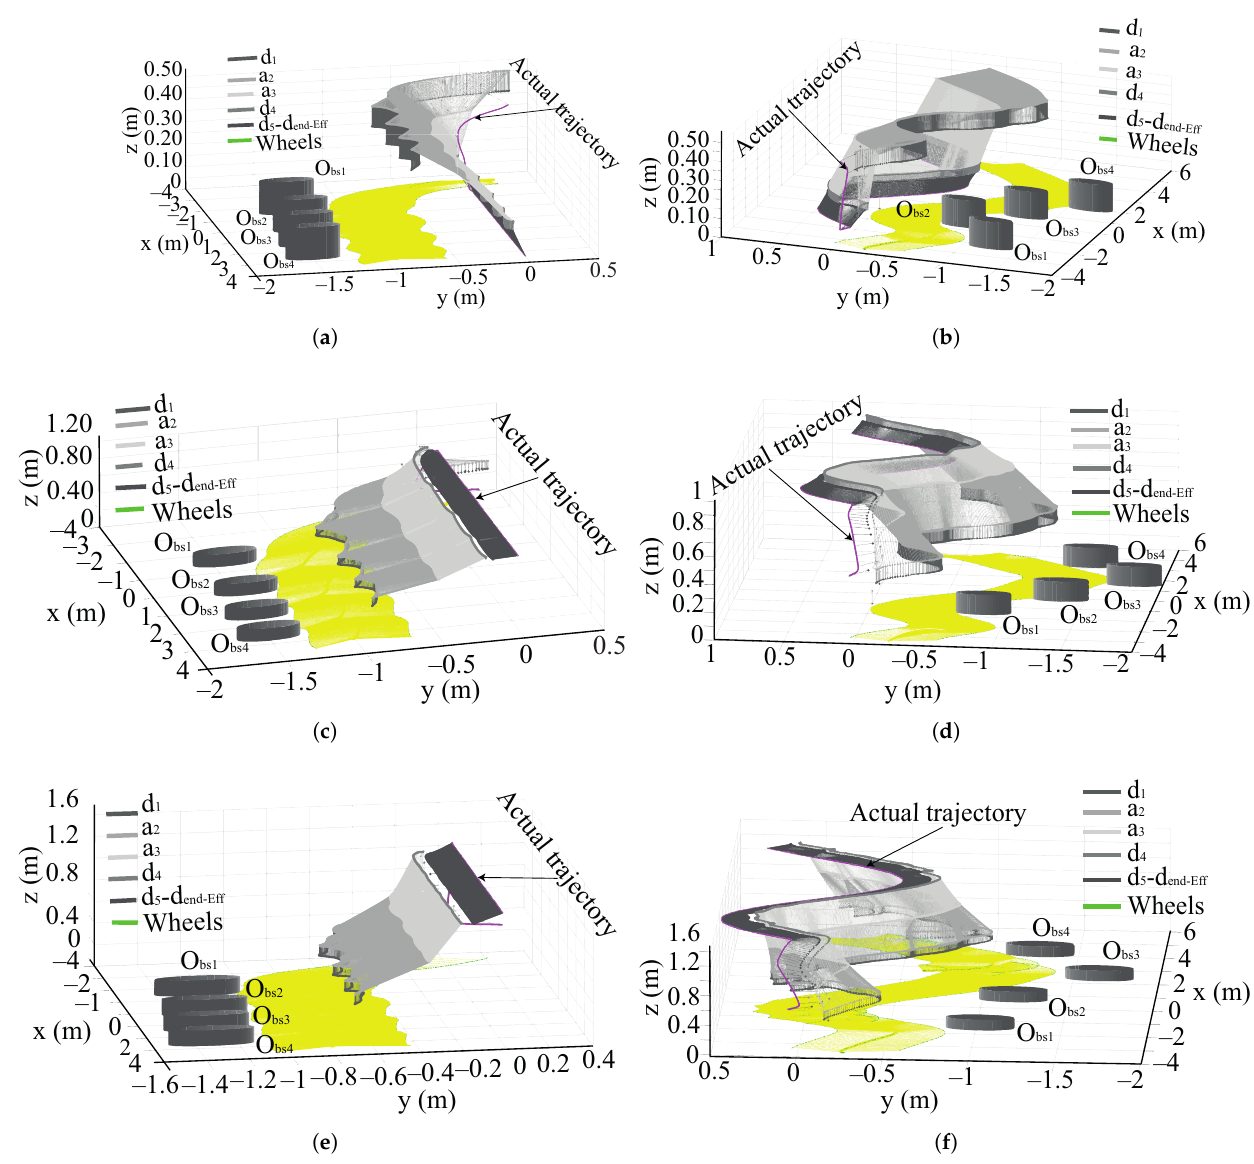
Figure 7. The solid magenta line describes the sinusoidal and straight printing profiles. ( a – f ) show the tests carried out for three heights, z 1 , z 2 and z 3 for a sinusoidal profile of 7 m radius and a straight profile of 6 m. For the sinusoidal building element, the shape of the printing workspace is also sinusoidal. For printing profile heights z 1 and z 2 , the mobile platform first avoids the obstacle and then maintains its position as the manipulator advances in 3D printing. For height z 3 , obstacle avoidance produces changes in the displacement of the mobile platform without affecting the sinusoidal shape of the printing workspace. The first column of Figure 8 shows the simulation environment with obstacles of the mobile manipulator in the CoopeliaSim software. The second column shows the four proposed printing profiles. The grey dashed line represents the displacement of the wheels of the mobile platform, and the solid cyan line describes the displacement of the centre. The black circle represents the obstacles. The magenta dashed line represents the current trajectory, and the solid black line is the reference